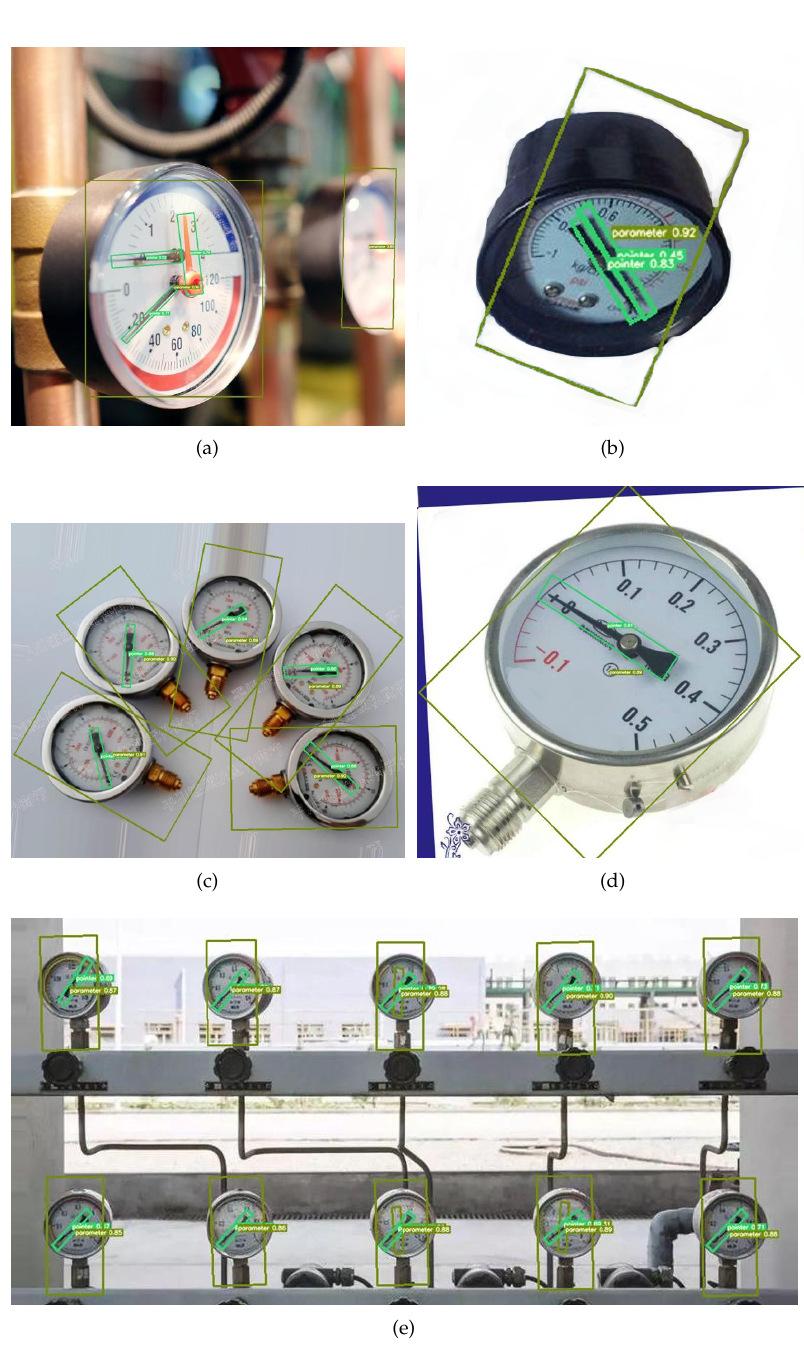
Figure 8. Annotation and prediction angle fitting